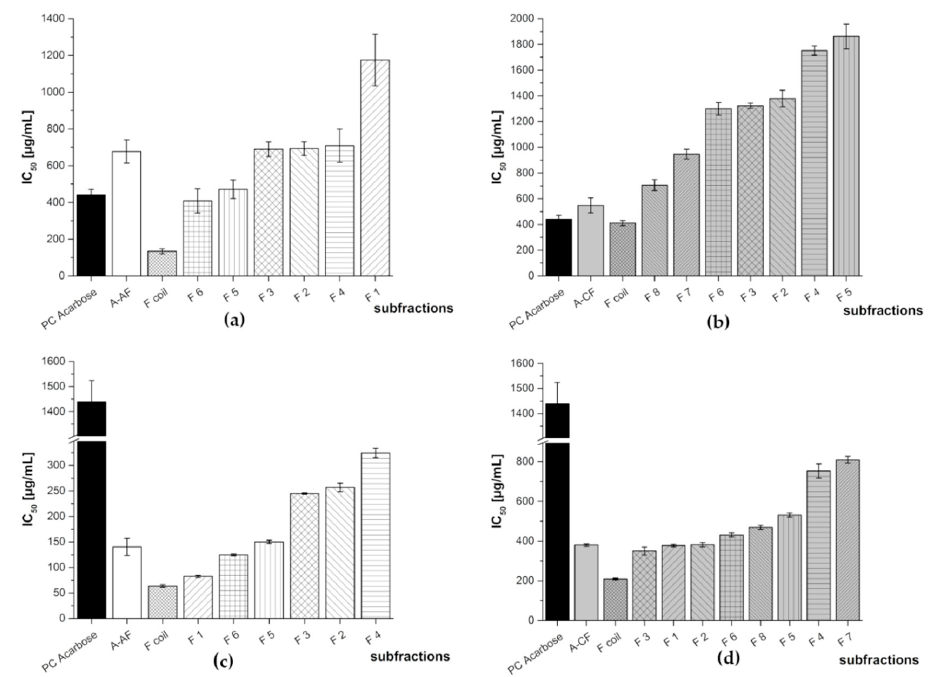
Figure 9. Inhibitory activities (IC 50 values) of the HPCCC subfractions of aronia NFC anthocyanin fraction (A-AF) and aronia NFC copigment fraction (A-CF) in comparison to the positive control (PC) acarbose. Results are presented as means ± SD ( n = 3). ( a ): A-AF α -amylase assay; ( b ): A-CF α -amylase assay (F1: N/A); ( c ): A-AF α -glucosidase assay; ( d ): A-CF α -glucosidase assay. N/A = not available. Table 4. Inhibitory activities (IC 50 values) of the HPCCC subfractions of aronia NFC anthocyanin (A-AF) and aronia NFC copigment fraction (A-CF). Results are presented as means ± SD ( n = 3). N/A = not available.